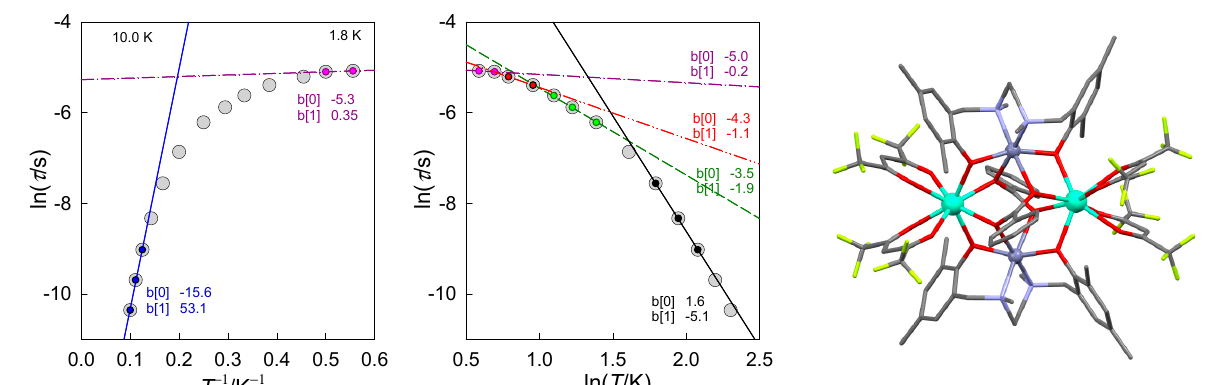
Figure 1. Different contributions to the relaxation time in [Dy III 2 Zn II 2 ] molecular complex: Orbach (high-temperature, blue, U eff / k B = 53 K), Raman (intermediate-temperature, black, n ~ 5), phonon bottleneck (low temperature, green, n ~ 2), direct (low-temperature, red, n ~ 1), quantum tunneling of magnetization (violet, n ~ 0). Straight lines: y = b[0] + b[1] x . Data adapted from ref. [23]. 2014, American Chemical Society.